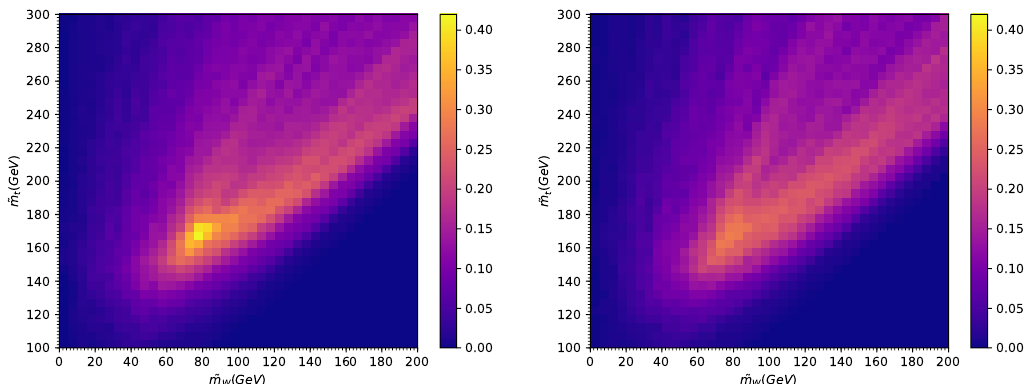
Figure 22 . Density of degeneracy curves for Standard Model dilepton t (cid:22) t events in the ( ~ m W ; ~ m t ) plane for ~ m (cid:23) = m (cid:23) = 0 GeV, without detector smearing (left) and with detector smearing (right). Unlike (cid:12)gures 16, 18 and 20, the density units here are fraction of events per 5 GeV, i.e., the bins are 5 GeV (cid:2) 5